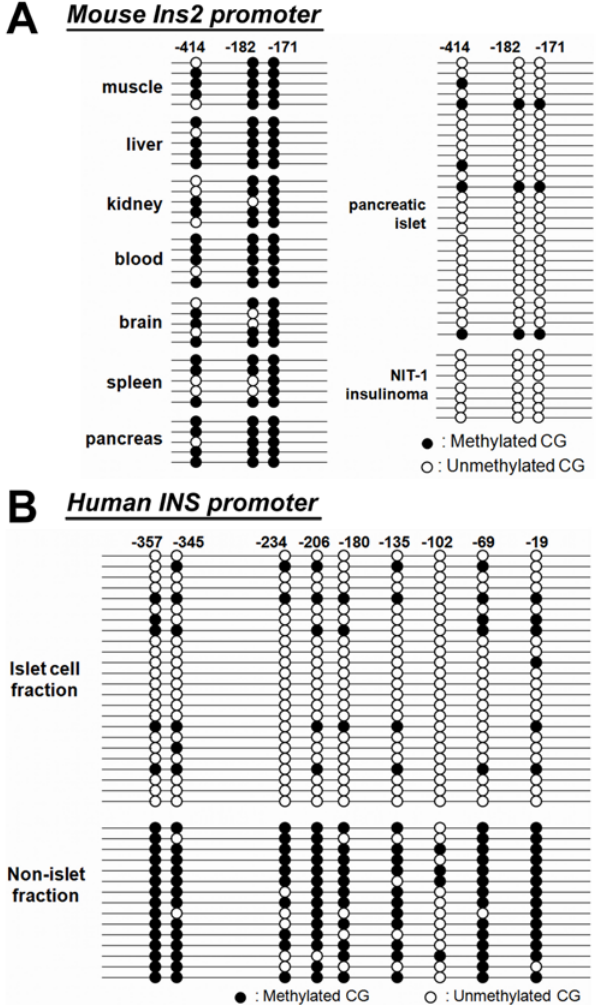
Figure 1. Tissue-specific methylation of the mouse Ins2 and human INS promoters. (A) Genomic DNA samples from mouse muscle, liver, kidney, blood, brain, spleen, whole pancreas, partially purified pancreatic beta cells ( , 70%), and the mouse NIT-1 beta cell line were analyzed for tissue specific methylation patterns of the mouse Ins2 promoter (position 2 480 to + 15 bp) which contains three potential methylation sites. (B) Genomic DNA samples obtained from human beta cells (‘‘Islet cell fraction’’; , 70% islet cells) and from human pancreatic exocrine tissue (‘‘Non-islet fraction’’; , 1% islet cells) were analyzed for methylation of the insulin promoter ( 2 385 – + 24 bp), which contains nine CpG sites. Note that 7 of 24 clones (29%) of the clones in the beta cell population exhibited some CpG methylation, consistent with the percentage of non-beta cell contamination.